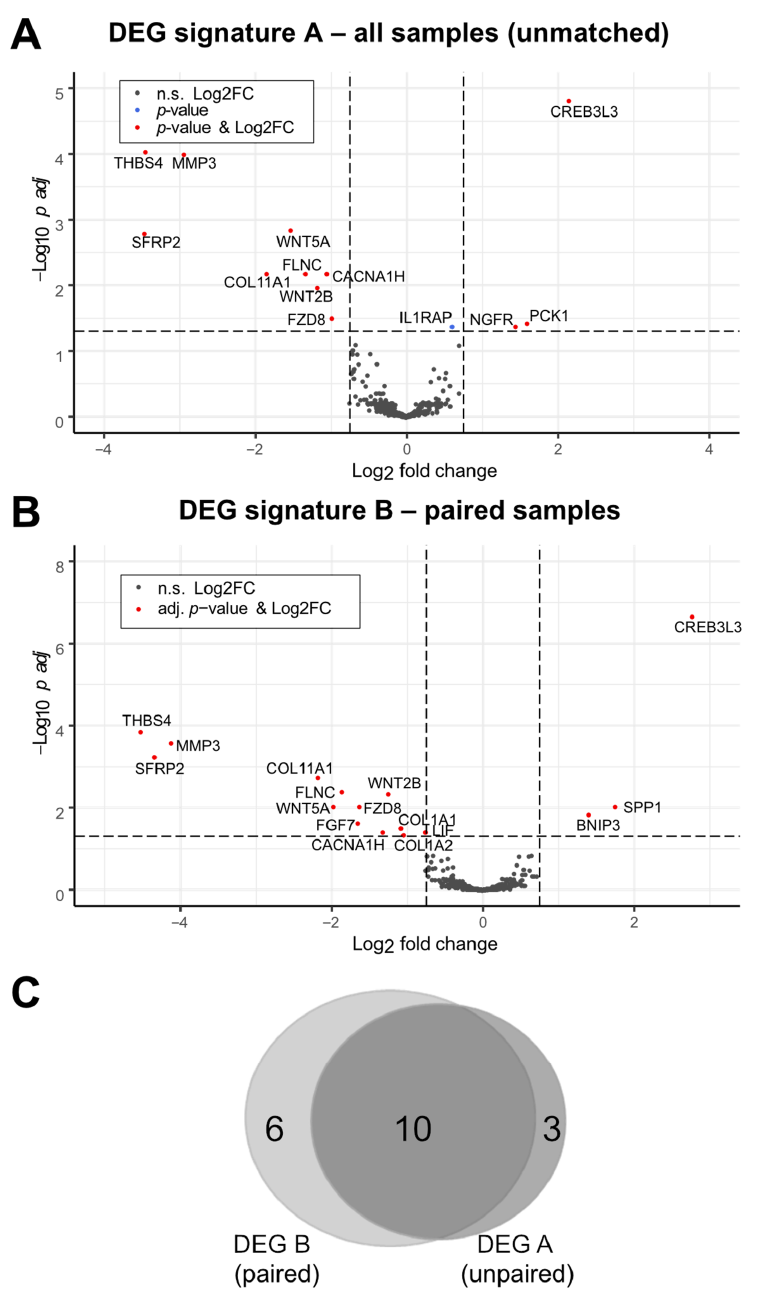
Figure 3. Identification of a post-therapeutic liver metastasis CRC expression signature. ( A , B ) Expression comparison in P and M tumor tissues in unmatched/all samples (( A ) P, n = 29; M, n = 22) and paired samples (( B ) P, n = 12; M, n = 12). Data were generated by moderated t -test with limma (padj, padjusted) and displayed by volcano plots. Differentially expressed genes (DEGs) are indicated by red dots. FC, fold change; n.s., not significant. p adj , p adjusted. ( C ) Venn diagram indicating the number of overlapping genes in DEG signatures A (unmatched) and B (paired).